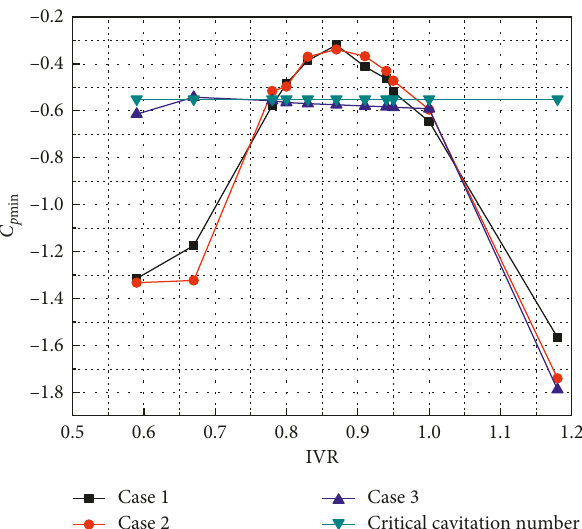
Figure 20: Minimum cavitation number C